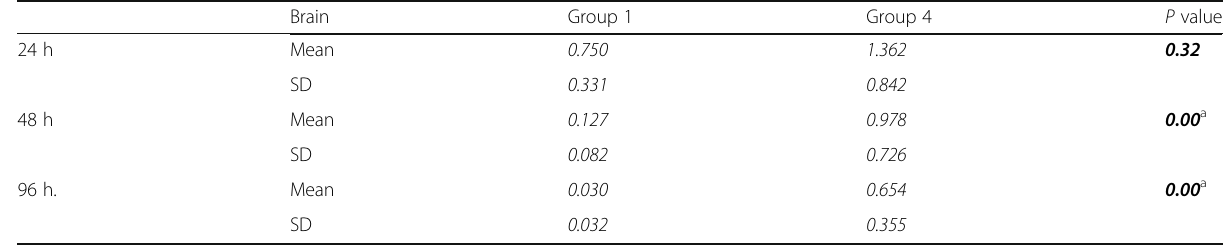
Table 5 Comparison between brain-GAPDH mean values of Air at 30 °C (group1) and 6 °C (group